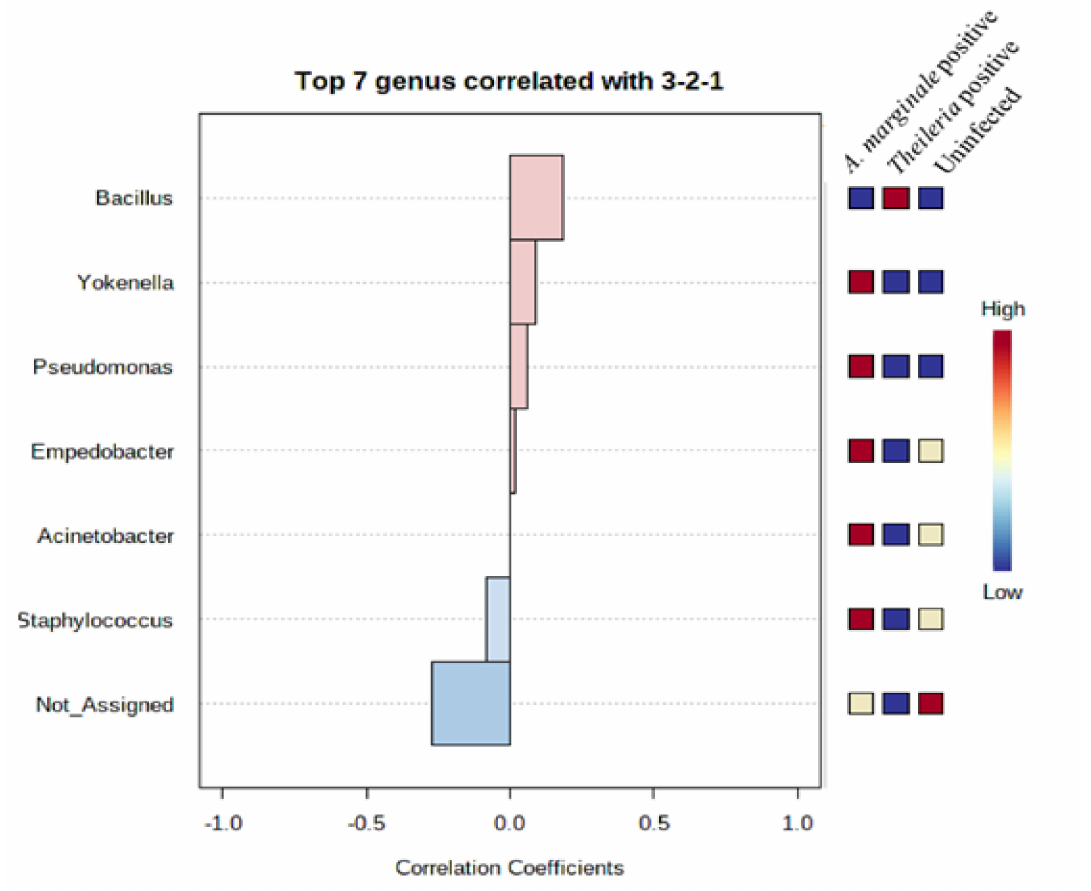
Figure 5. Pattern correlation analysis of top 7 bacteria genera in R. microplus ticks. Ticks positive with Theileria sp. showed a positive correlation with the presence of